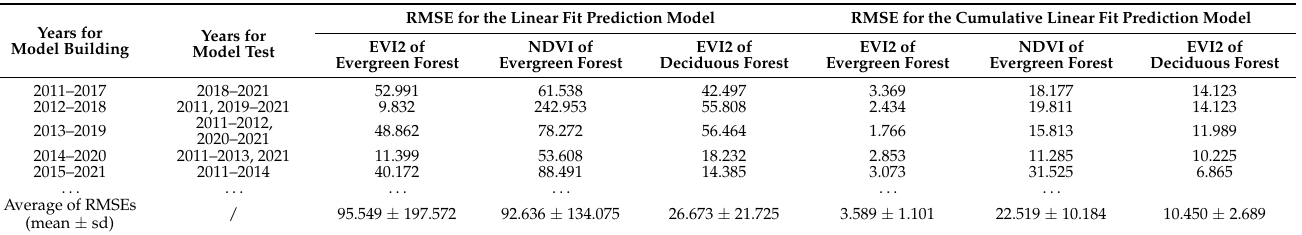
Table 4. Cross-test results of the prediction models based on EVI2 of evergreen forest, NDVI of evergreen forest and EVI2 of deciduous forest for 330 training